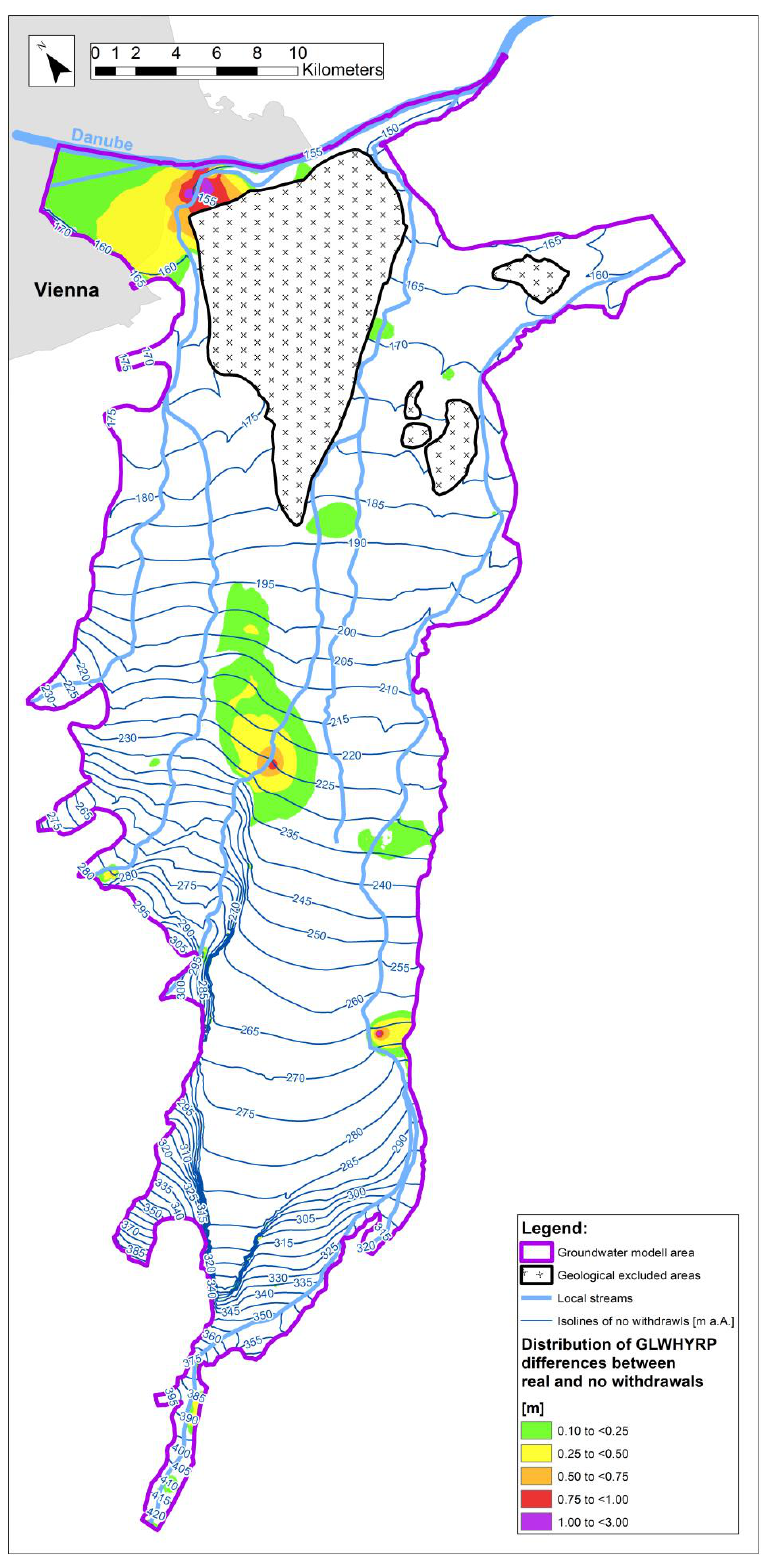
4 Figure 6. Distribution of GLsWHYRP based on modelled groundwater levels for no